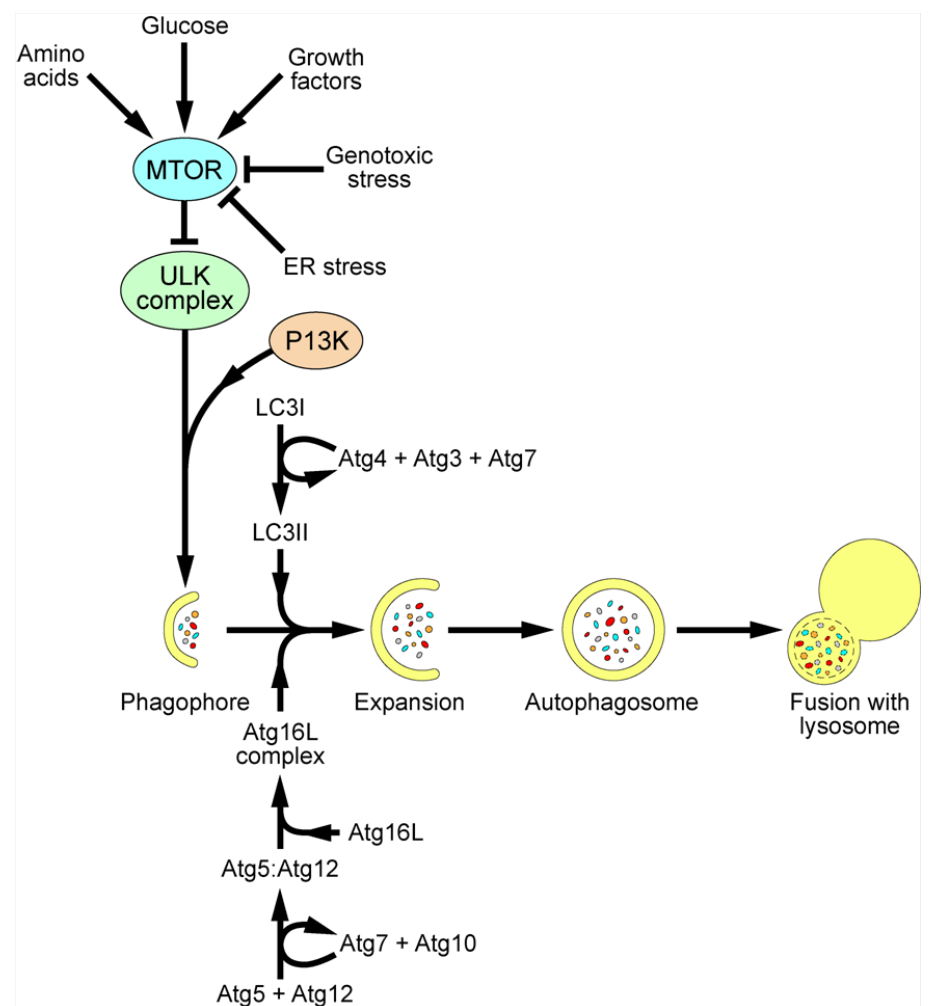
Figure 2. Schematic of mammalian autophagy pathway. MTOR is the major control complex for autophagy. MTOR senses levels of amino acids, glucose and growth factors, as well as genotoxic and ER stress. Upon stimulatory signals, MTOR becomes inactivated and the ULK complex becomes hypophosphorylated and relocalises to the phagophore, along with PIP3, produced by class III PI3K complexes. The Atg16L complex and LC3II are also recruited to the growing autophagosome, allowing expansion of the membrane and fusion to give a complete autophagosome, engulfing organelles, aggregated proteins and intracellular pathogens. The autophagosome then fuses with a lysosome, resulting in the degradation of the contents and recycling of nutrients into the